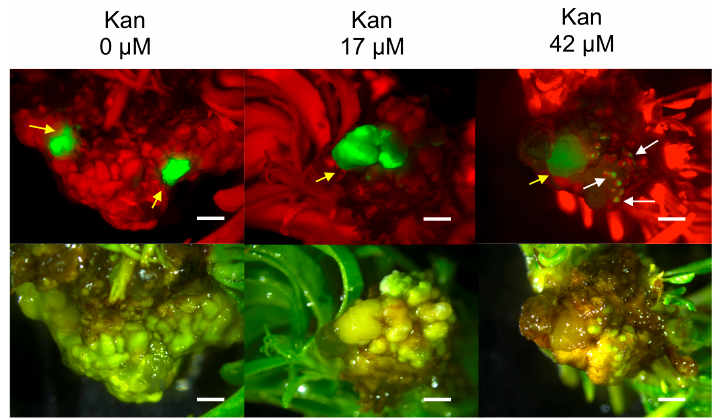
Figure 2. Hansen 536 GFP fluorescing spots and/or Lzs detected on MB slices at three weeks after co-culture on medium with 0, 17 or 42 μ M Kan. White and yellow arrows indicate examples of GFP spots and large zones of fluorescent actively growing calli, respectively. Uniform bright green fluorescence was observed under UV light. Upper and lower panels show images taken under UV and white light, respectively (bar = 2 mm).